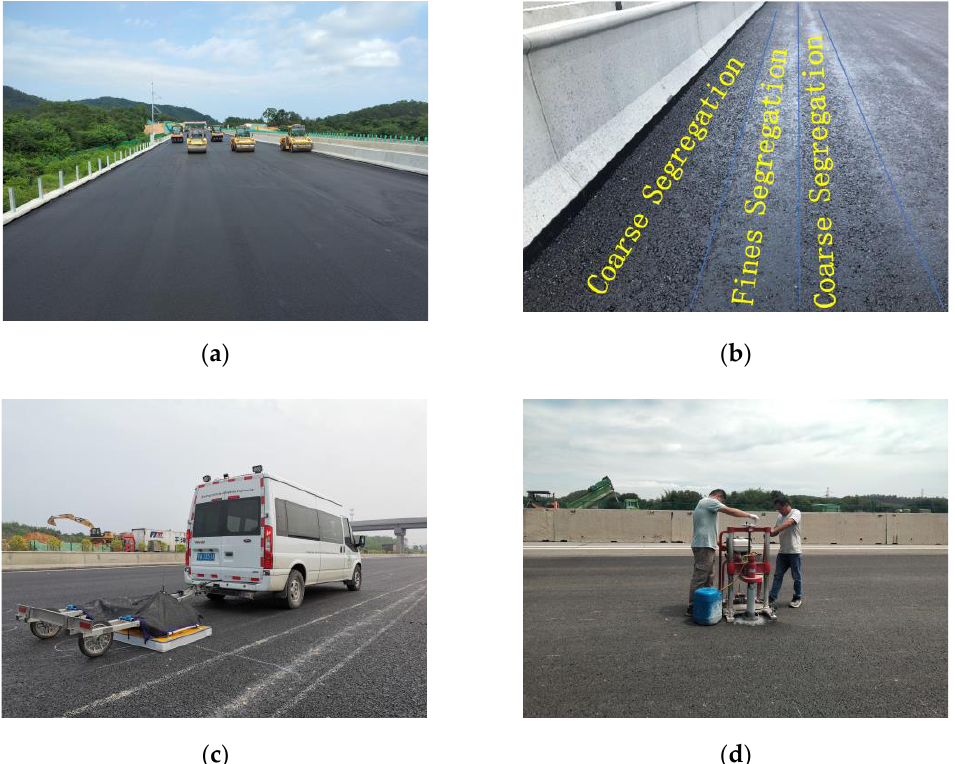
Figure 10. Physical engineering test. ( a ) Construction of the lower layer of asphalt. ( b ) Strip agglomeration area of low and high compaction level aggregates on the surface. ( c ) 3D GPR scanning. ( d ) Void ratio measurement in low compaction level segregation risk area.